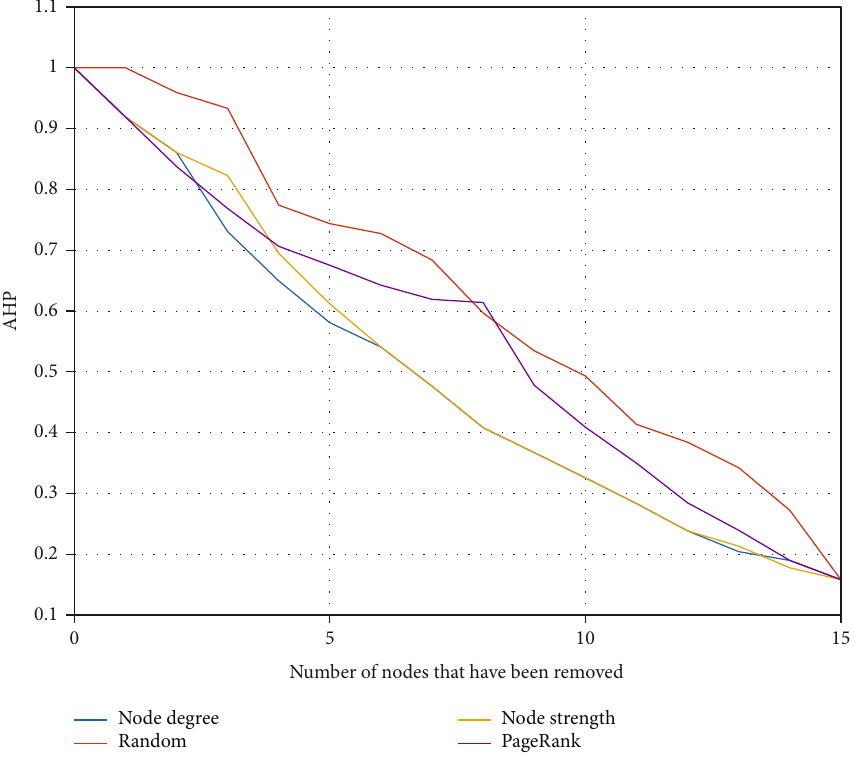
Figure 16: The e ff ect of the ODS removal order on network performance degradation